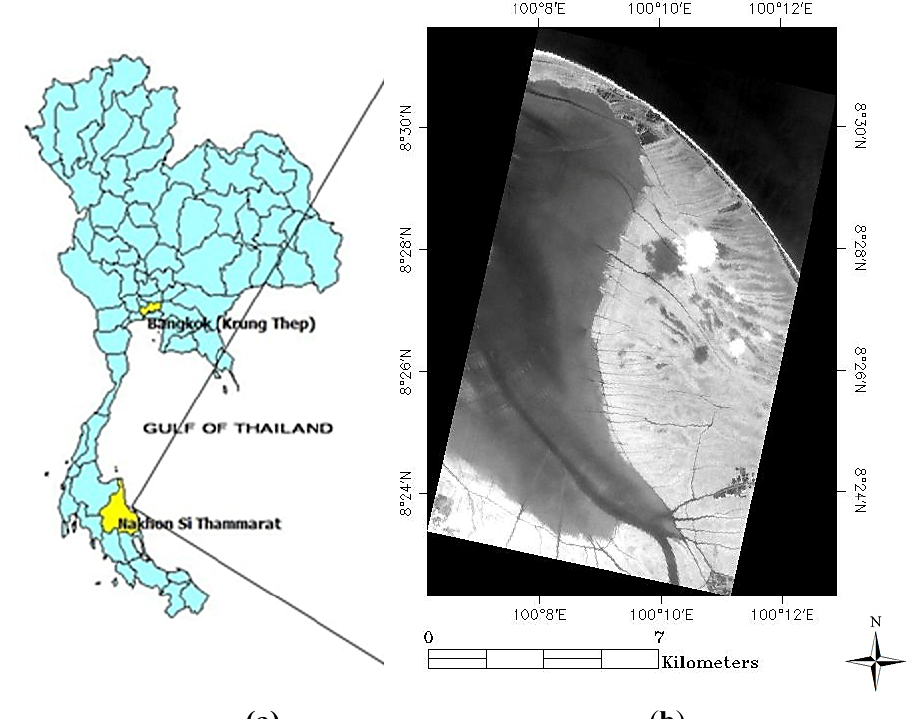
Figure 1. The location of the Talumpuk cape ( a ), Pak Phanang District, Nakorn Sri Thammarat Province, Thailand shown against an enlarged satellite image of the cape ( b ) captured by the EO-1 Hyperion sensor on 29 June